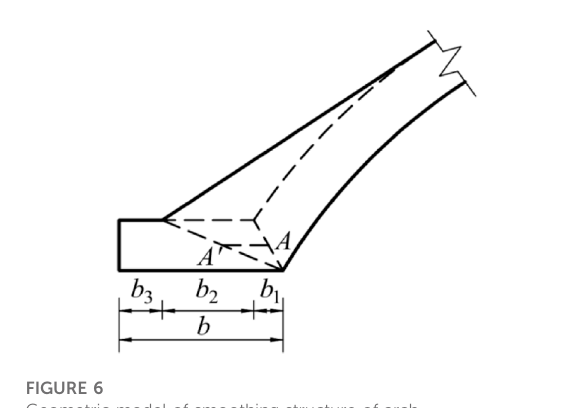
FIGURE 6 Geometric model of smoothing structure of